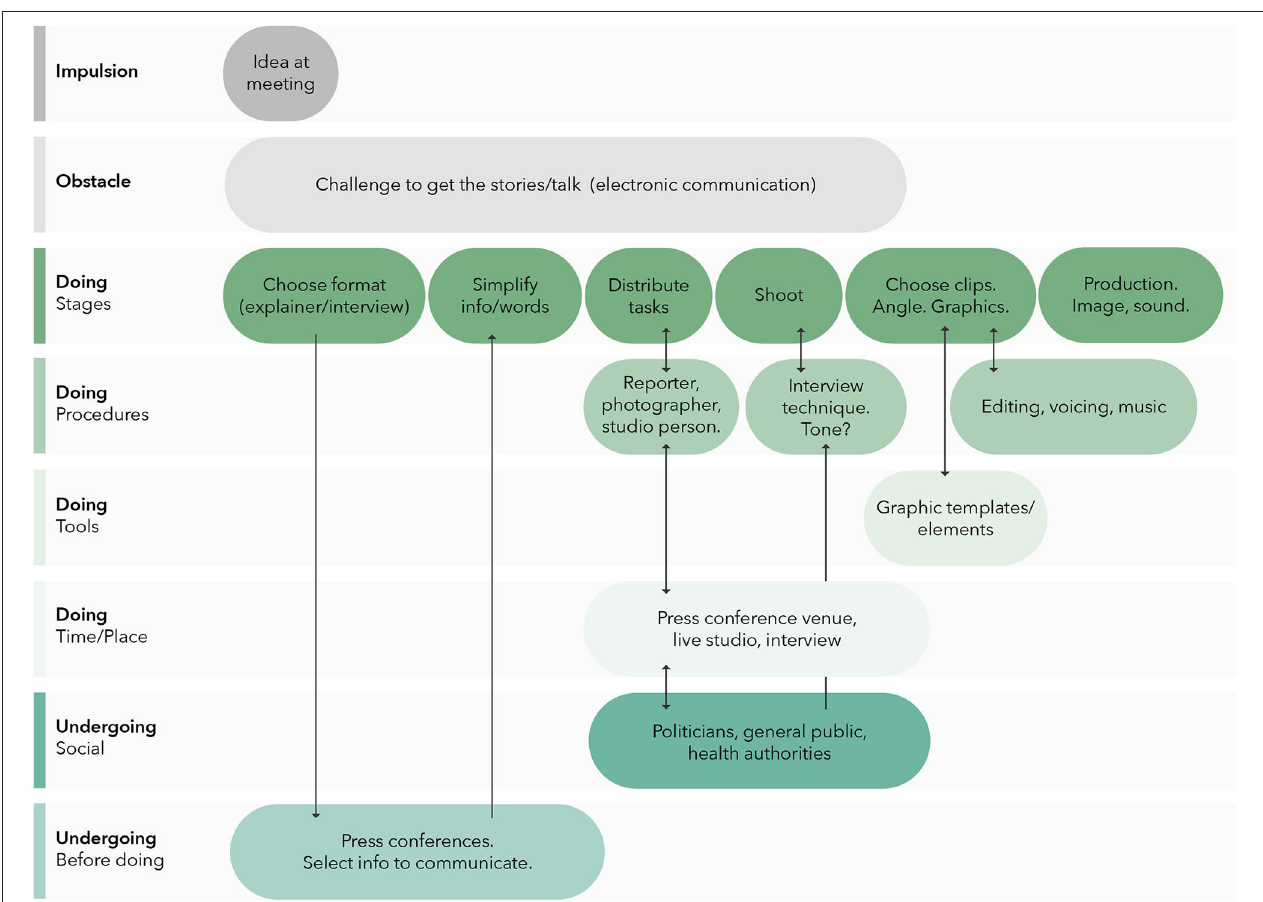
FIGURE 5 | A flow chart representation of creative activity as explained by video